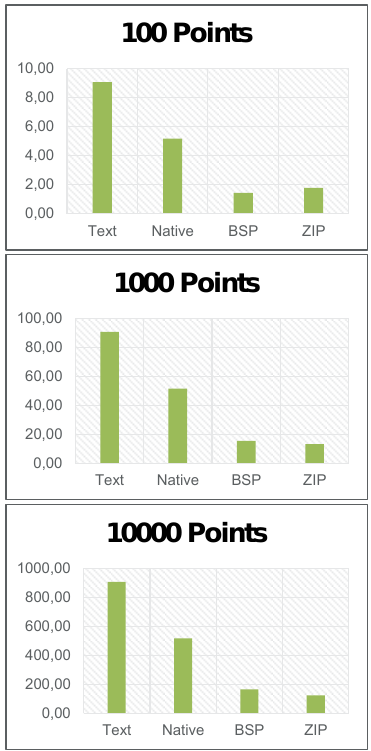
Figure 6. Data volumes (KiB) in different formats for 3